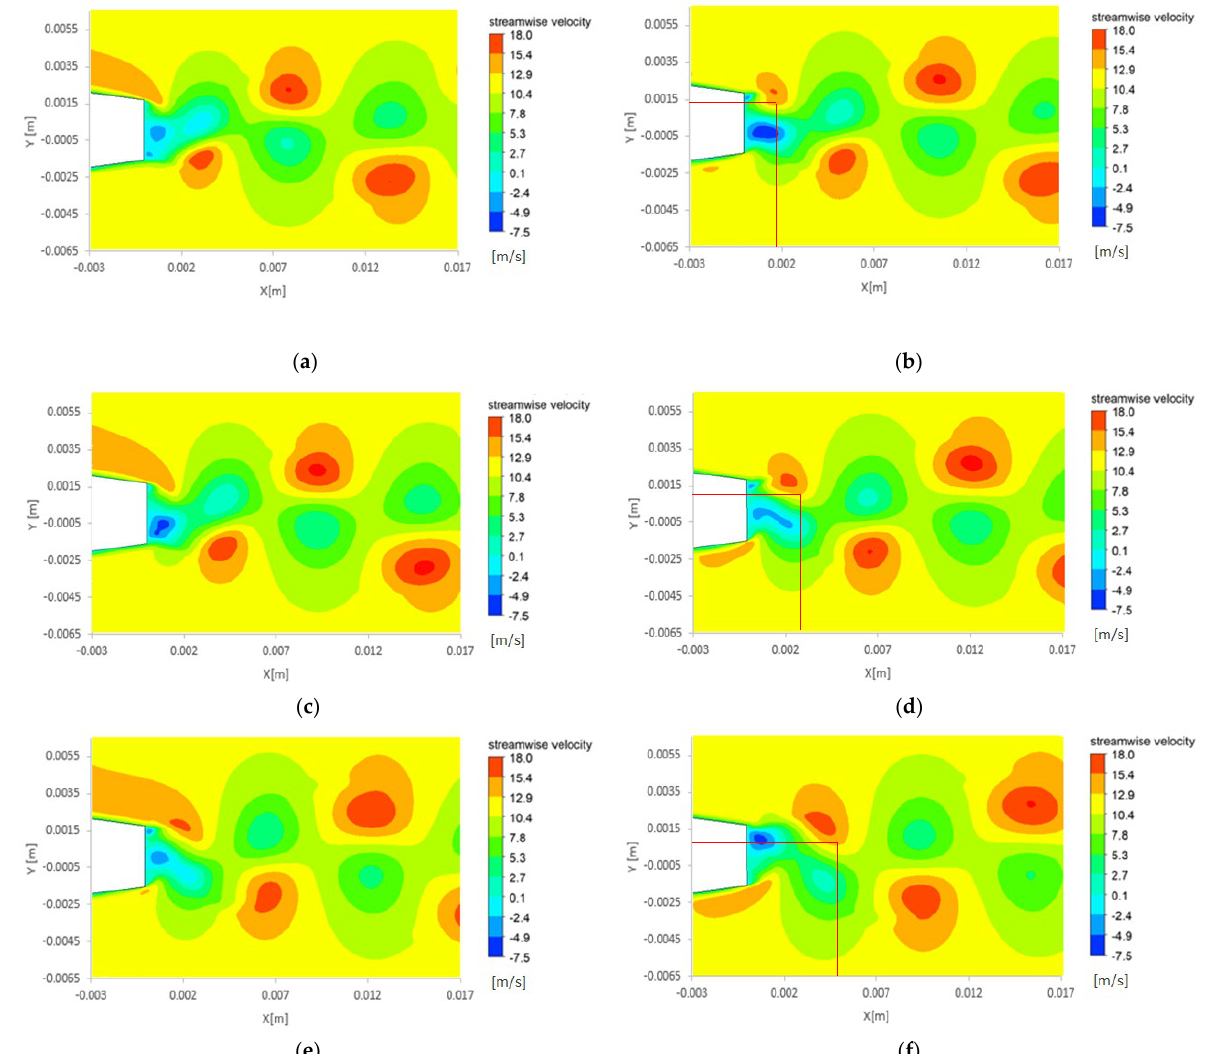
( a , b ), ( c , d ), and ( e , f ) regimes at t/T = 0 ( a , c , e ) and t/T = = 2 ( a , b ), σ = 0.98 ( c , d ), and σ = 0.69 ( e , f ) regimes at t / T = 0 ( a , c , e ) and σ i σ i σ i 𝜎𝜎 𝜎𝜎 𝜎𝜎 𝜎𝜎 𝑖𝑖 = 2 𝜎𝜎 𝑖𝑖 = 0.98 𝜎𝜎 𝑖𝑖 = 0.69